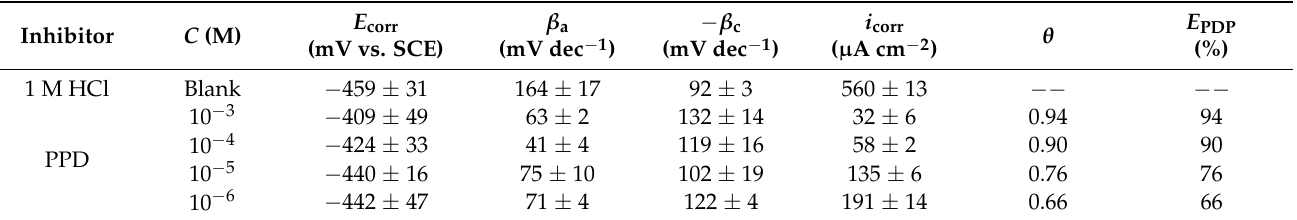
Table 2. Tafel polarization parameters for steel/HCl electrochemical system without and with various PPD